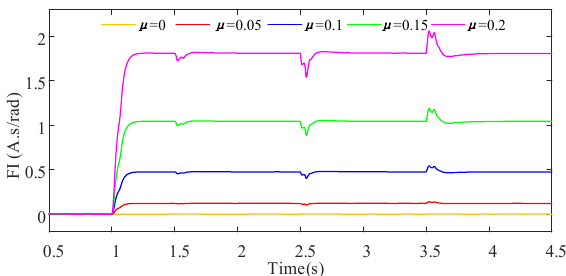
Figure 12. Fault detection results under stepped wind speed with different μ .